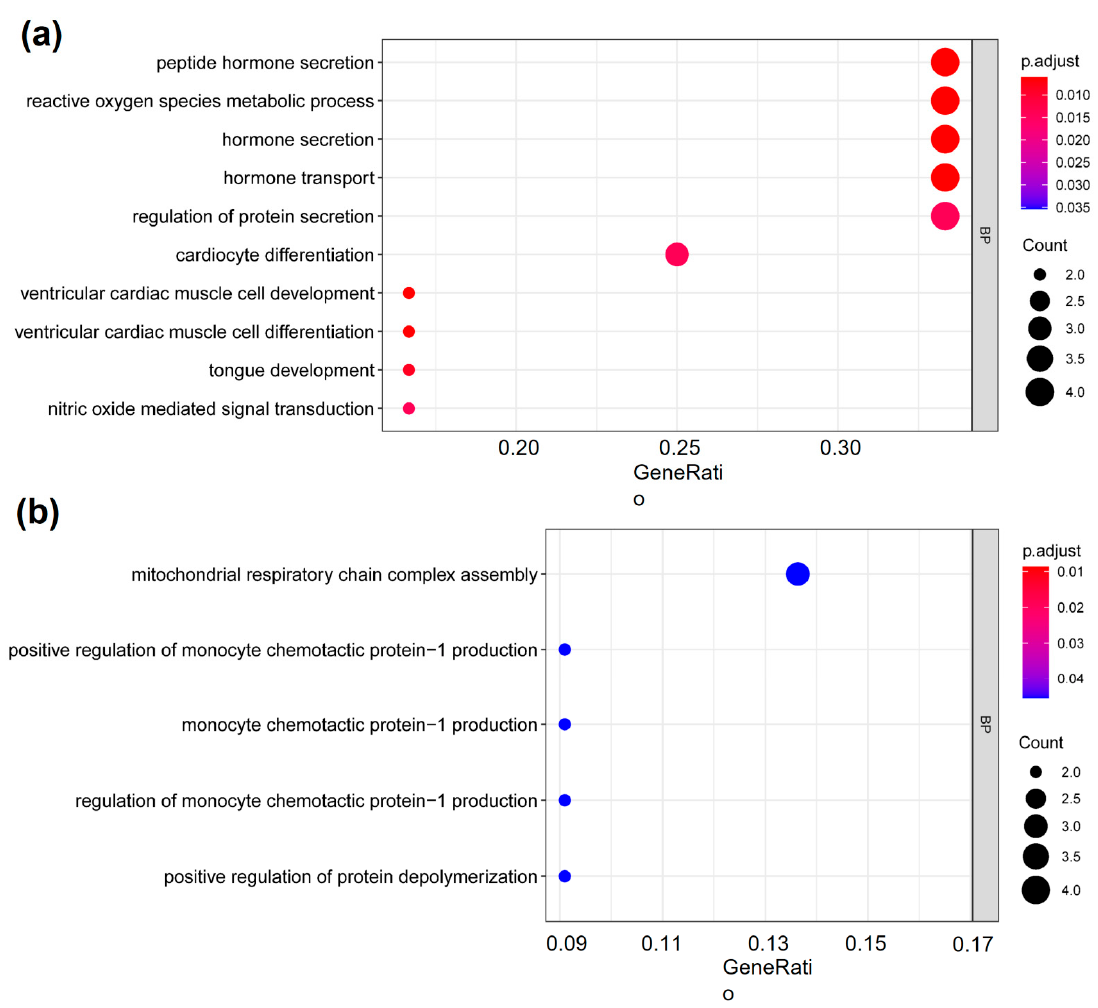
Figure 4. Genes with deH3K4me3 from ICSI-girls were enriched in ‘cardiocyte differentiation’ term. GO enrichment analysis of the genes with deH3K4me3 from ( a ) ICSI-girls and ( b ) ICSI-boys. The y-axis represented the significantly enriched terms (adjusted p -value < 0.05) in BP. The x-axis represented the GeneRatio (the ratio of the number of differential genes on the GO pathway to the total number of differential genes). The size of the dots represented the gene counts. The color gradient from red to blue meant the adjusted p -value from low to high. BP, biological process.